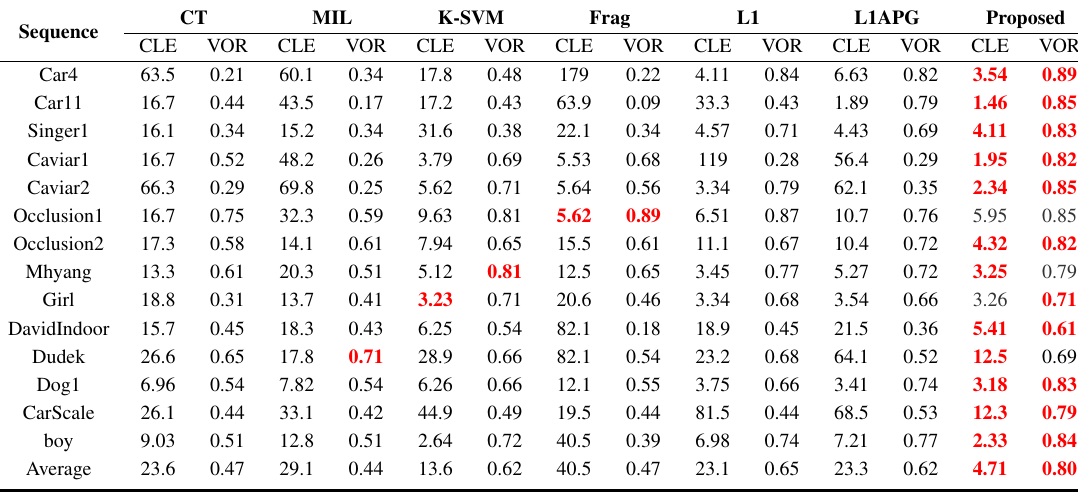
Table 3. Speeds and implementations of the tracking methods. Fps, frames per second. Tracker CT Proposed Average Fps